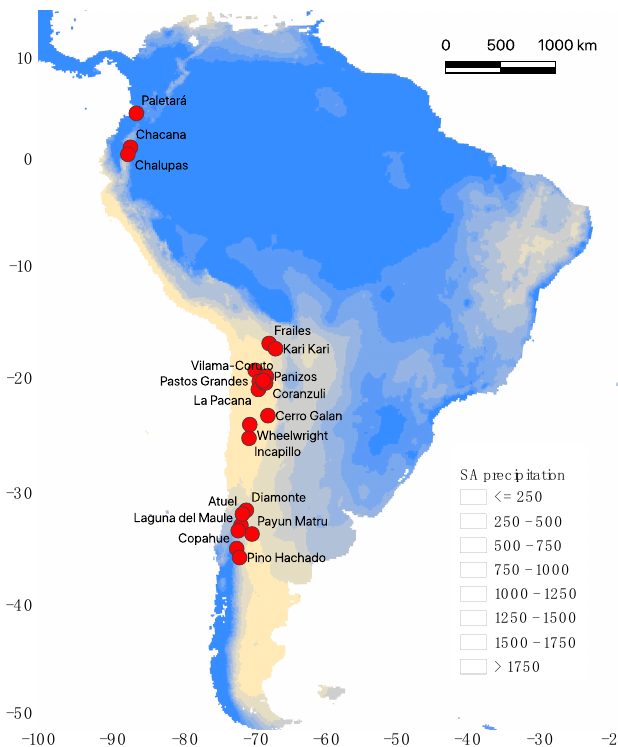
Figure 5. Locations of major late Cenozoic calderas (generally >10 km in diameter) in the Andes, from [51,52]. Map shows mean annual rainfall in mm from 190–2000, from worldclim.org. Calderas are dominantly found in the arid to hyperarid parts of the range.